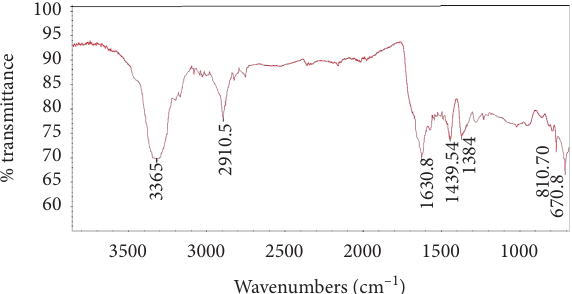
Figure 4: FTIR spectrum of the SCF resin.